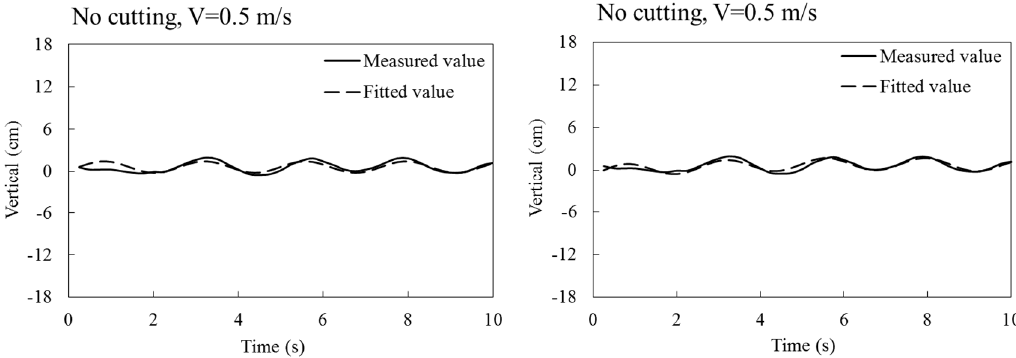
Figure 9. Comparison of the fitted value and the measured value of the end point height for codends with catch using different order Fourier series (an example: ( left ): using the first-order Fourier series; ( right ): using the second-order Fourier series). Table 2. Correlation of measured value and fitted value of the end point height for codends by the Pearson product- moment correlation coefficient. Cutting Ratio